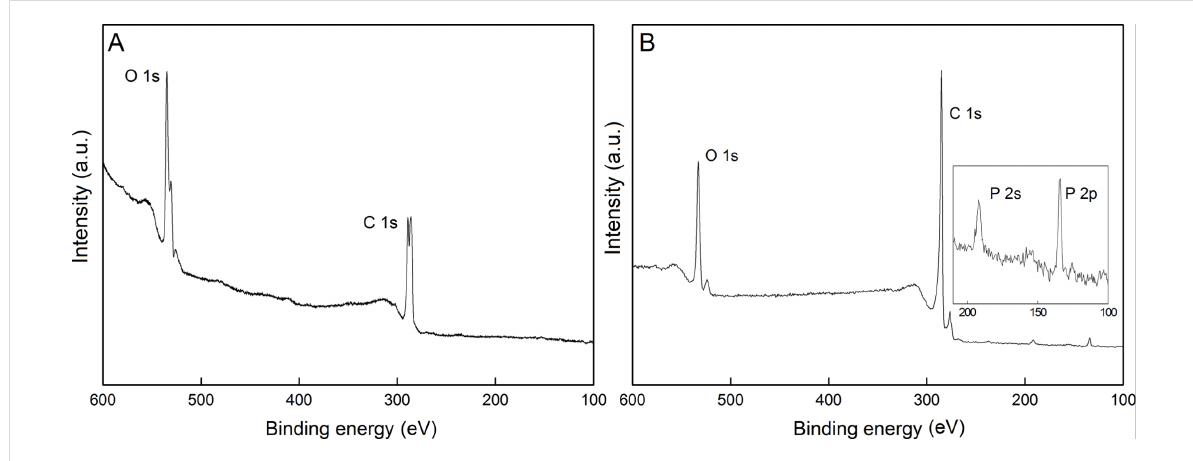
Figure 6: XPS spectra of A) GO and B) GO-P. The inset shows an enlarged view of the energy region characteristic for P.